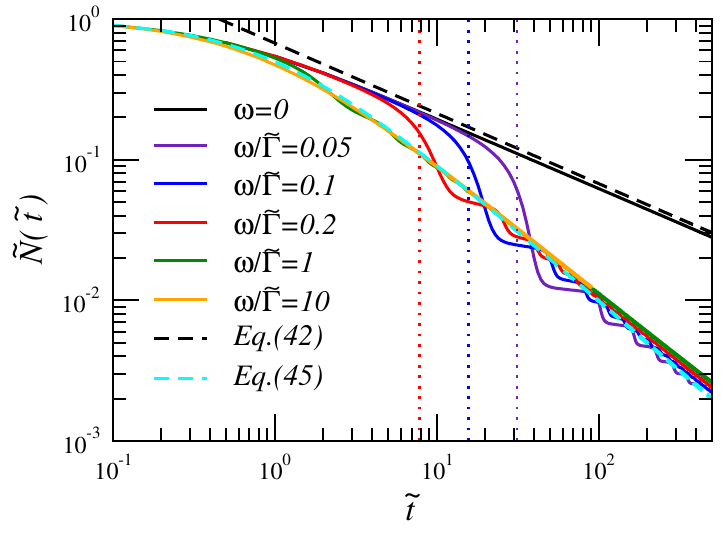
Figure 3: Time-evolution of the normalized density ˜ N ( ˜ t ) for different values of the ratio ω/ ˜ Γ . Black and cyan dashed lines are theoretical prediction for the weak and strong confinement case, Eq. (42) and Eq. (45) respectively. Vertical dashed lines = T / 4 for ω/ ˜ Γ = 0.05,0.1,0.2 (purple, blue and red mark the threshold time t ω tr line,